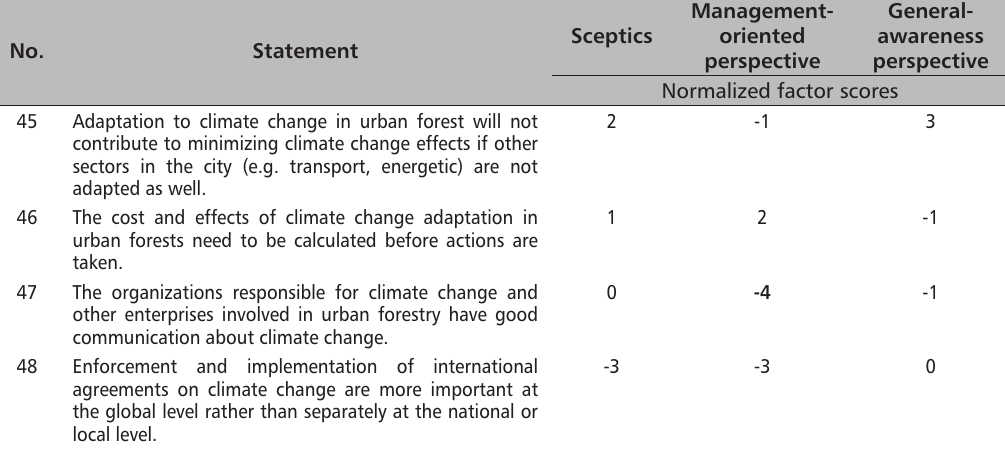
TABLE 2. List of statements used in Q-methodology with normalized factor scores for each statement and perspective [29] - continuation